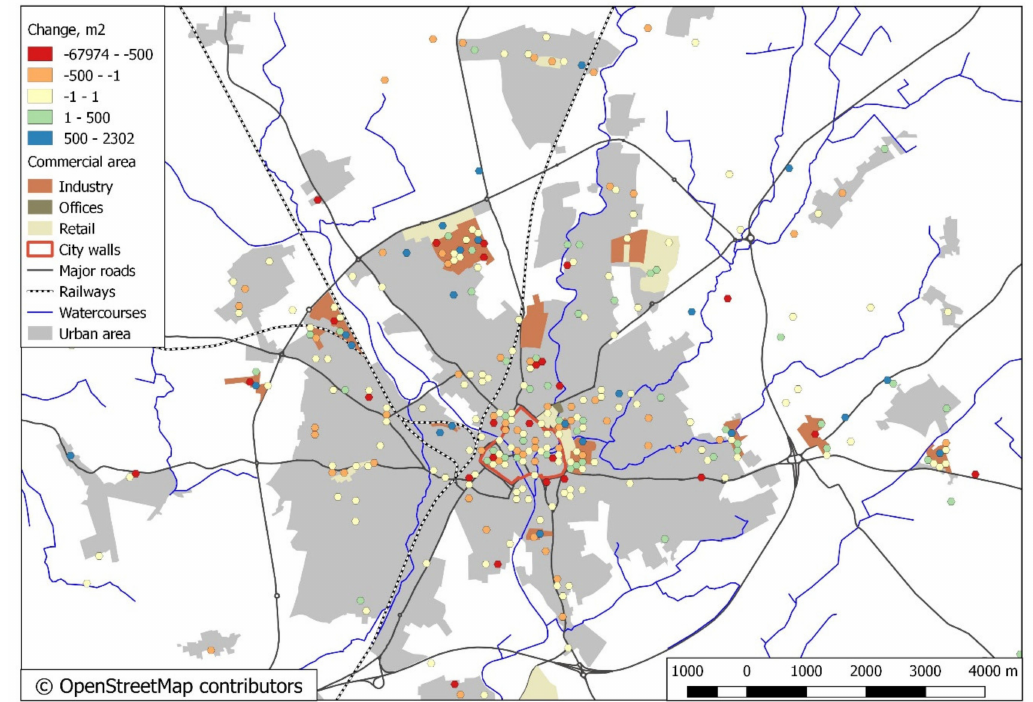
Figure 11. Change in industrial property floorspace distribution, 2010–2017.